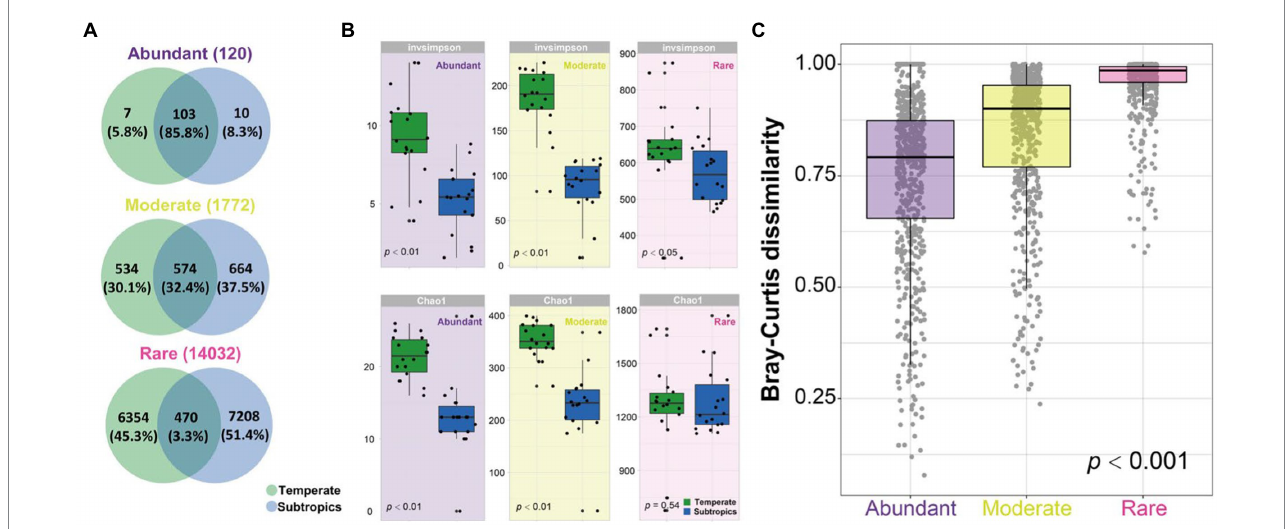
FIGURE 3 (A) Venn diagram showing the number of OTUs (120 abundant OTUs, 1,772 moderate OTUs, and 14,032 rare OTUs) that are unique and shared between two groups. (B) The alpha diversity of abundant, moderate, rare subcommunities in temperate and subtropics. (C) The boxplot shows community dissimilarities of abundant, moderate, and rare taxa.